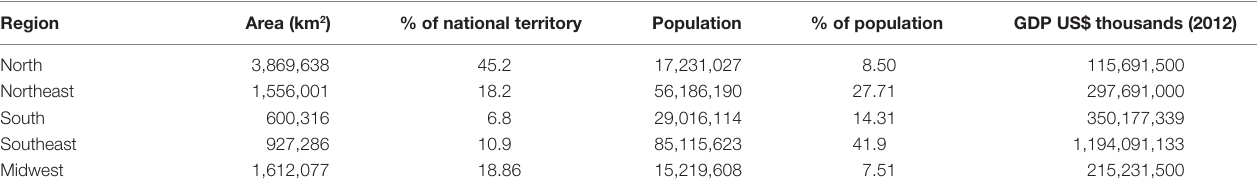
TaBle 3 | geo-economic characteristics of Brazilian states by region.